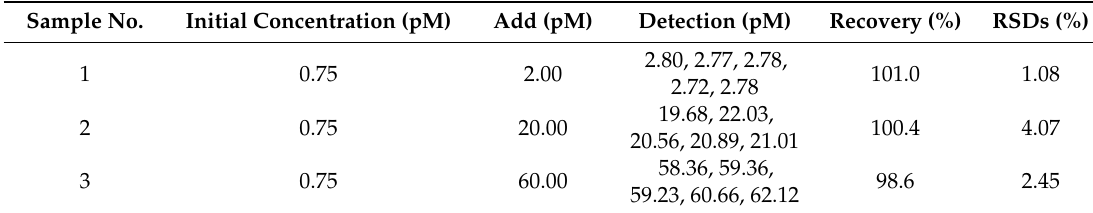
Table 2. The detection of tau-381 in human serum samples.